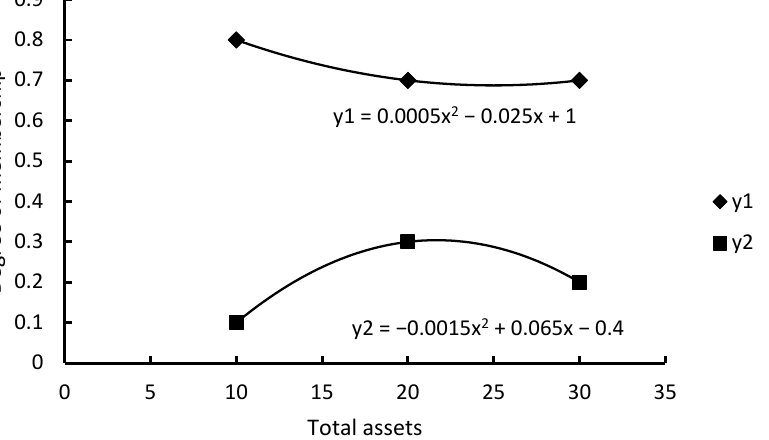
Figure A4. Single factor evaluation for the index of total assets (10–30 (inclusive) ten thousand yu- an).